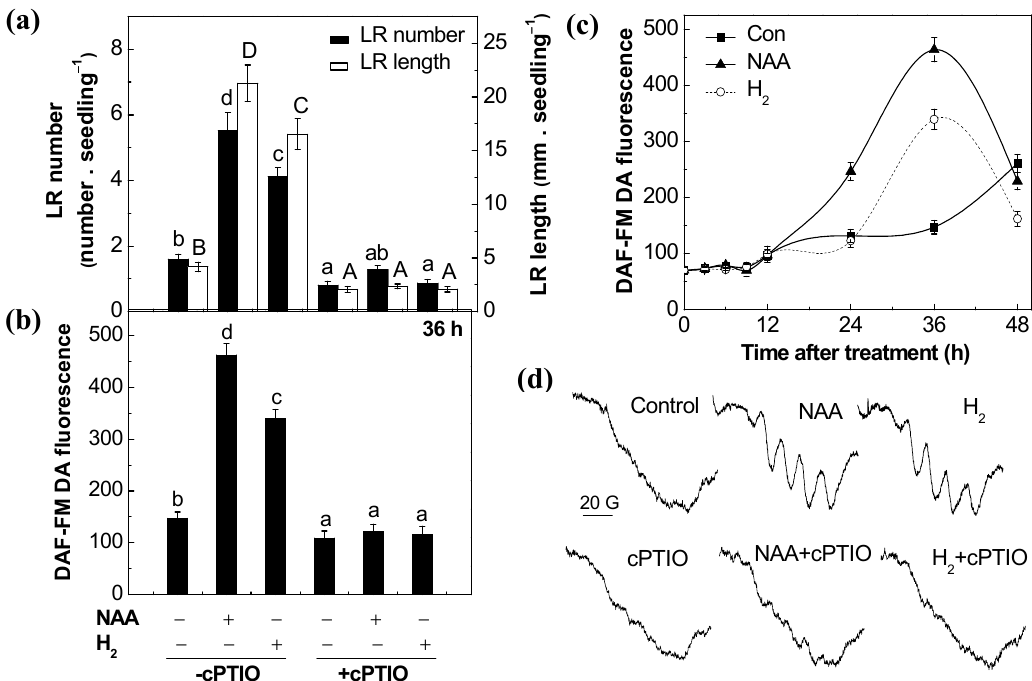
Figure 3. H 2 -induced nitric oxide (NO) production and lateral rooting were sensitive to the removal of NO by 2-4-carboxyphenyl-4,4,5,5-tetramethylimidazoline-1-oxyl-3-oxide (cPTIO), a NO scavenger. 3-day-old tomato seedlings were incubated with solutions containing 200 nM NAA, 0.39 mM H 2 , and 200 µ M cPTIO, alone or the combination treatments. ( a ) The number of emerged LRs (>1 mm) per seedling and LR length were calculated after 3-day of treatments. Meanwhile, the NO fluorescence in tomato roots was analyzed by fluorescence probe DAF-FM DA at 36 h ( b ) and over 48 h; ( c ) of treatments, respectively, using laser scanning confocal microscopy (LSCM) (TCS-SP2 system; Leica Lasertechnik GmbH). The DAF-FM DA fluorescence density was analyzed using Leica software. ( d ) The NO signal was also detected by electron paramagnetic resonance (EPR) after being treated for 36 h. Distilled water was used for the control (Con) treatment. Data are the means ± SE of three independent experiments with at least three replicates for each ( n = 60 for lateral root formation analysis; n = 5 for NO detection). Within each set of experiments, bars denoted by the same letter did not differ significantly at p < 0.05 level according to Duncan’s multiple range test.